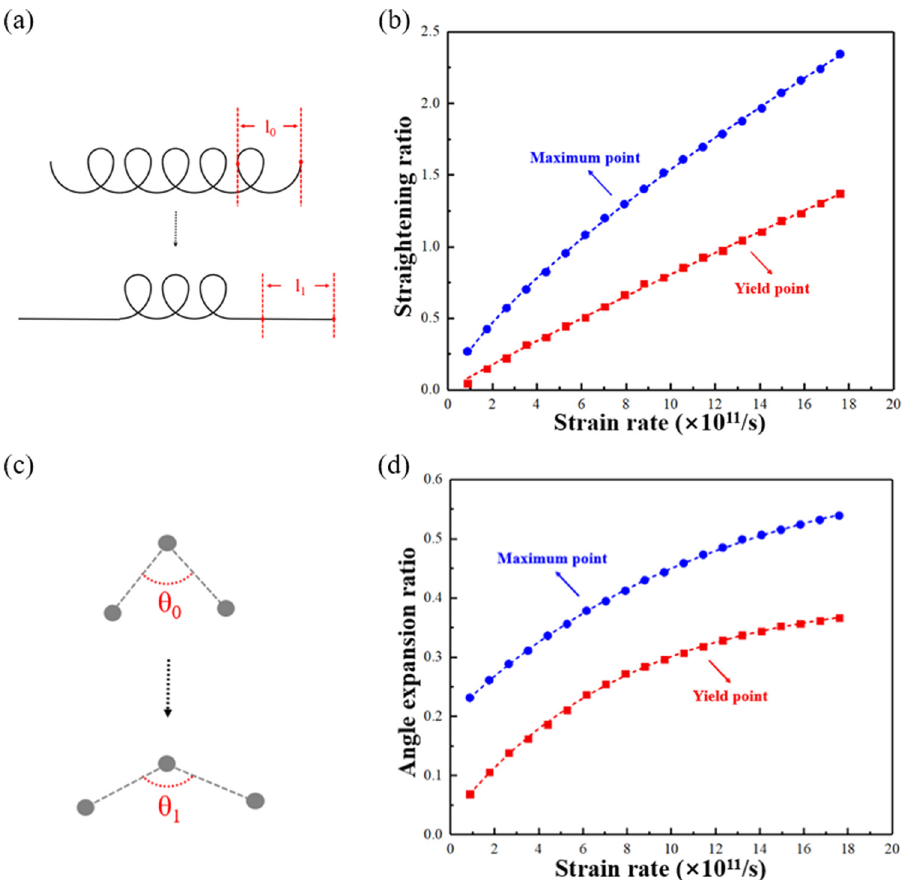
Figure 10: Quantitative analysis on the straightening of characteristic molecular chain in the disentanglement part upon dynamic loading: ( a ) schematic diagram of the straightening of characteristic molecular chain; ( b ) strain rate dependences of straightening ratio, R stress point and maximum stress point; ( c ) schematic diagram of the bond angle expansion among three neighboring atoms; and ( d ) strain rate dependences of the angle - expansion ratio, R a , at yield stress point and maximum stress